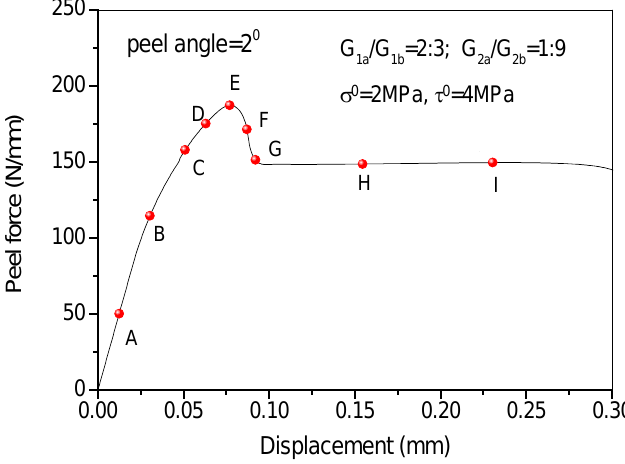
Figure 15. Load-displacement curves when peel angle = 2 degree.